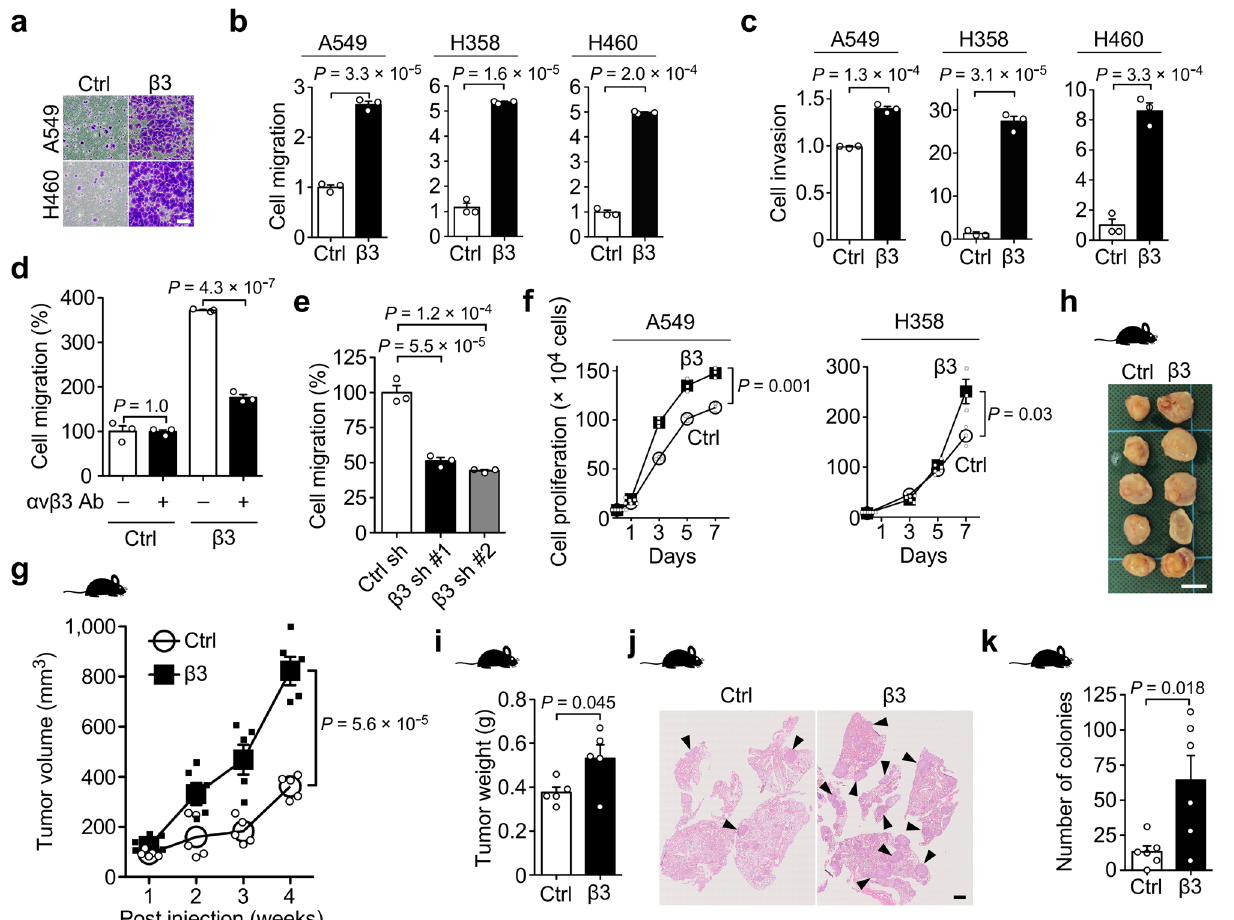
Fig. 3 Enhancement of migration, invasion, tumorigenicity, and metastasis by α v β 3 integrin. a Representative images of migrated control and β 3-A549 cells or control and β 3-H460 cells in Boyden chamber assays. Scale bar, 100 µ m. b , c Effect of α v β 3 integrin expression on the cell migration ( b ) and invasion ( c ) of A549, H358, and H460 cells. Two-tailed unpaired Student ’ s t -test, mean ± s.e.m. of three independent assays conducted in triplicate. d , e Effect of anti- α v β 3 integrin antibody ( d ) and β 3 integrin-speci fi c shRNA knockdown ( e ) on the cell migration of A549 ( d ) and H1975 ( e ) cells, respectively. One-way ANOVA and Bonferroni post-hoc test, mean ± s.e.m. of three independent assays conducted in triplicate. f Cell proliferation assays of control and β 3-A549, or control and β 3-H358 cells. Two-tailed unpaired Student ’ s t -test, mean ± s.e.m. of three independent assays conducted in quadruplicate. g Tumor growth of control and β 3-A549 cells in nude mice. Two-tailed unpaired Student ’ s t -test, mean ± s.e.m., n = 5 mice per group. h Representative picture from the tumors of control and β 3-A549 cells in nude mice at 4 weeks. Scale bar, 1 cm. i Primary tumor mass of control and β 3-A549 cells in nude mice at 4 weeks. Two-tailed unpaired Student ’ s t -test, mean ± s.e.m., n = 5 mice per group. j , k Representative pictures from H&E-stained lungs ( j ), and quanti fi cation of lung colonies ( k ) at 7 weeks after tail vein injection of control and β 3-A549 cells in nude mice. Arrowheads indicate tumor colonies. Scale bar, 1 mm. Two-tailed unpaired Student ’ s t -test, mean ± s.e.m., n = 6 mice per group. The source data are provided in Supplementary Data